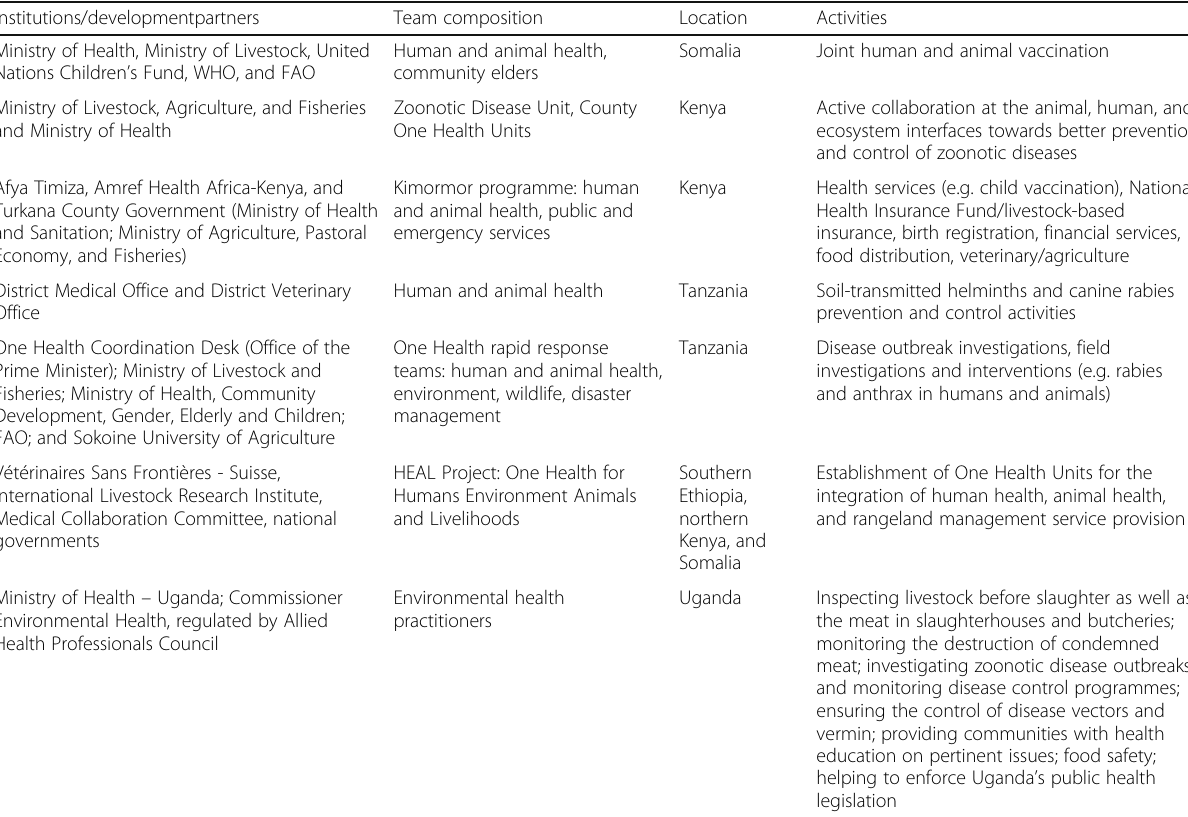
Table 3 Examples of a One Health approach in pastoral areas in the GHA (Griffith et al. 2020; Kamadjeu et al. 2015; Lankester et